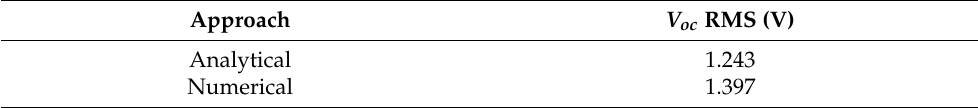
Table 2. RMS values of the OCV calculated by means of the analytical and numerical models.